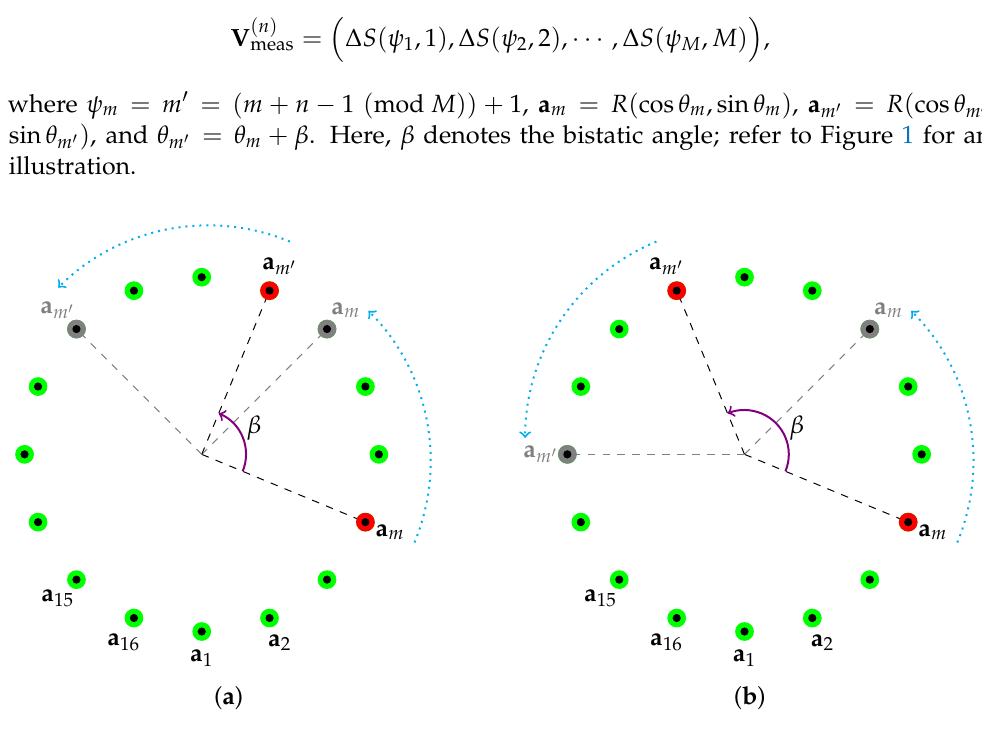
Figure 1. Illustration of bistatic measurement configuration. ( a ) n = 4 case, ( b ) n = 6